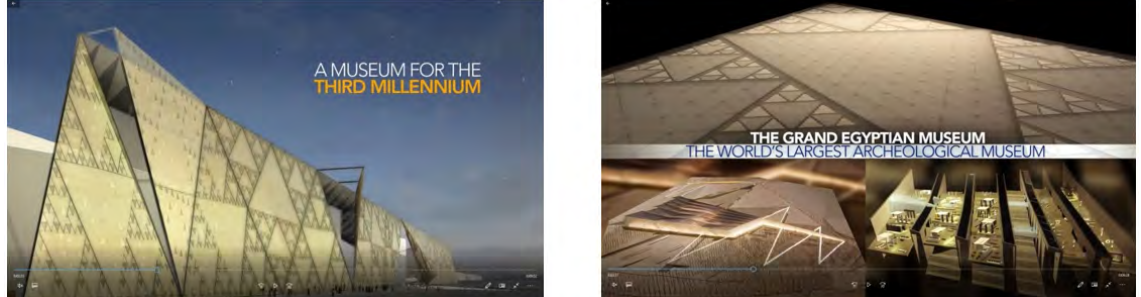
Figure 11. Shows the iconic grand Egyptian museum(New Egypt Old Friends, 2016)